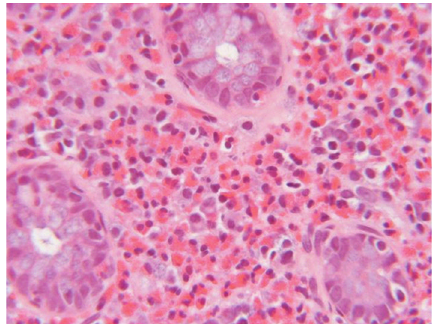
Figure 3: Microscopic view of the colon wall demonstrating tissue